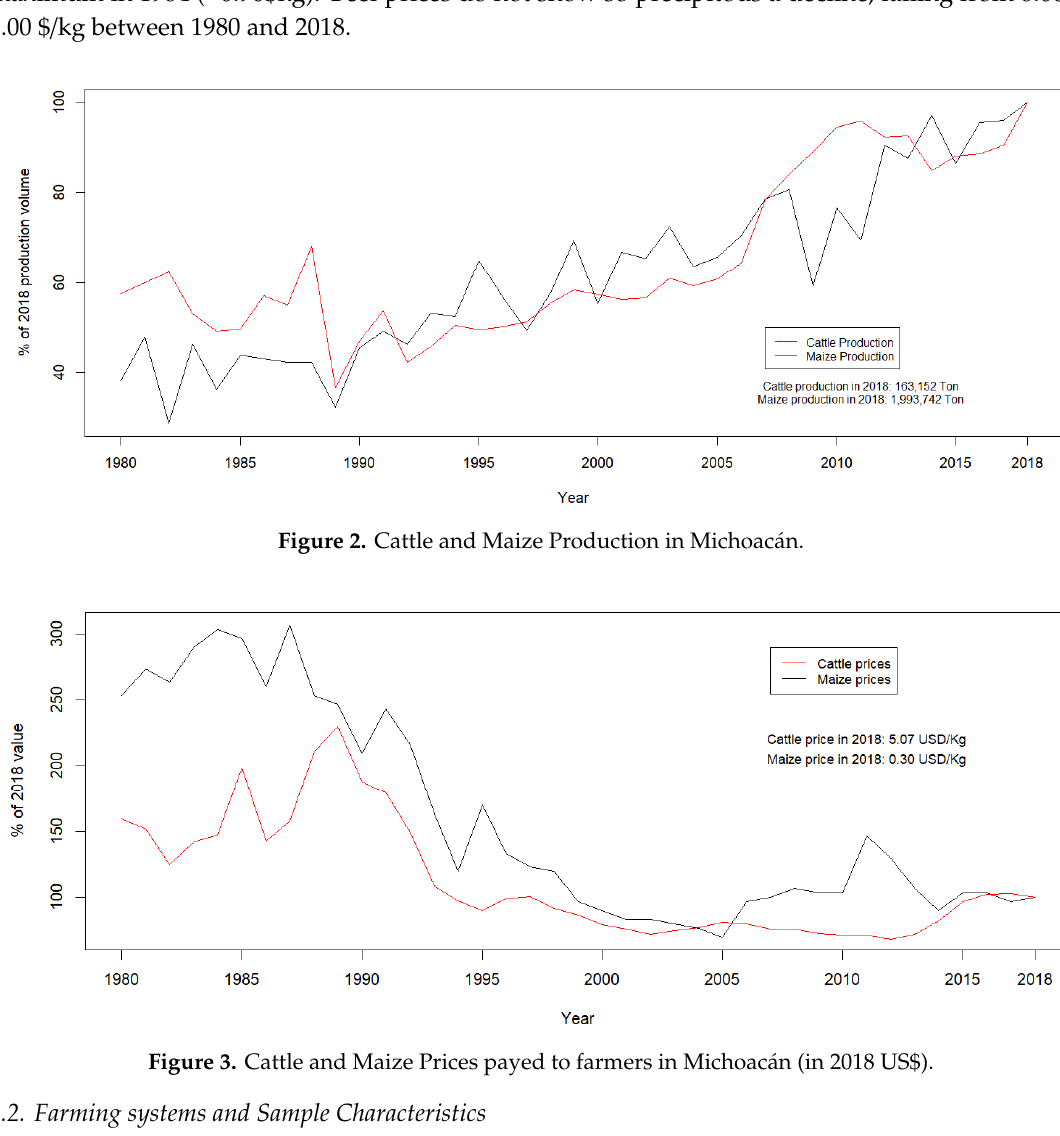
Table 2. General characteristics of the households (N = 130).